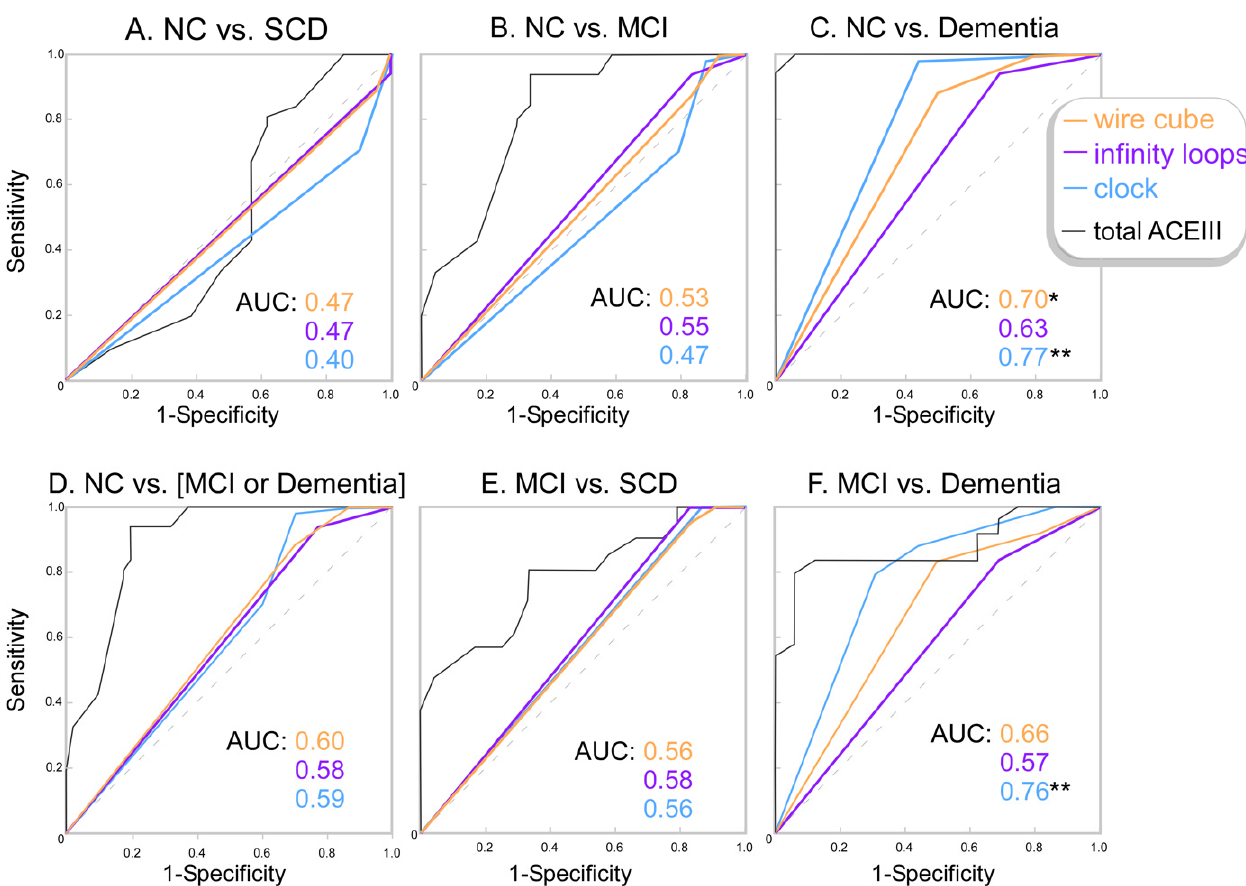
Figure 3 . ROC Curves and the corresponding area under the curve (AUC) for drawing tests scores . * p < 0.05; ** p < 0.01 if the AUC was significantly greater than the diagonal line (0.5) the test did distinguish between the two